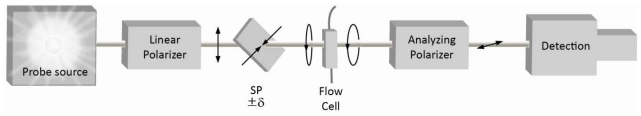
Apparatus for near-null ellipsometric time-resolved measurements of circular dichroism. Elliptically polarized light of high eccentricity is generated by sending initially unpolarized light through the first linear polarizer and then a strain plate (SP), which introduces a small phase retardance (δ). Right and left elliptically polarized light (REP and LEP) are obtained by rotating SP around its vertical axis by 180°. A circularly dichroic sample will change the eccentricity of elliptically polarized light because this light comprises components of LCP and RCP light with different amplitudes. After the sample, the LEP and REP probe light travel through a second, analyzing polarizer, and the minor axes (horizontally polarized light) of the two beams are detected by either an intensified photodiode array or intensified charge coupled device.